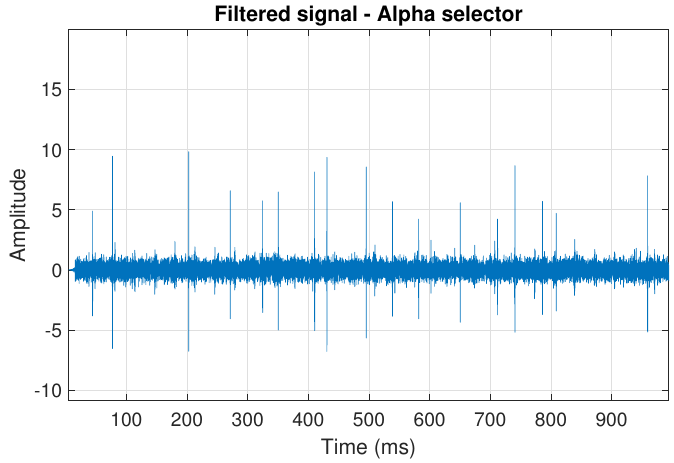
Figure 5. Filtered signal s 1 by Alpha selector.